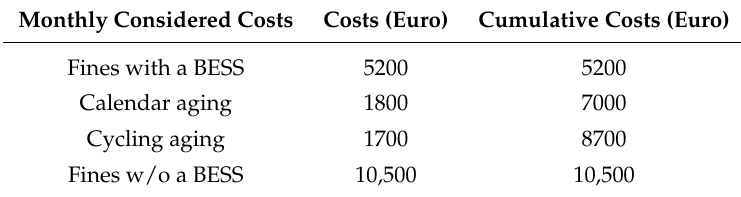
(cid:82) | P ( t ) − P ∗ ( t ) | dt at the PCC level with and